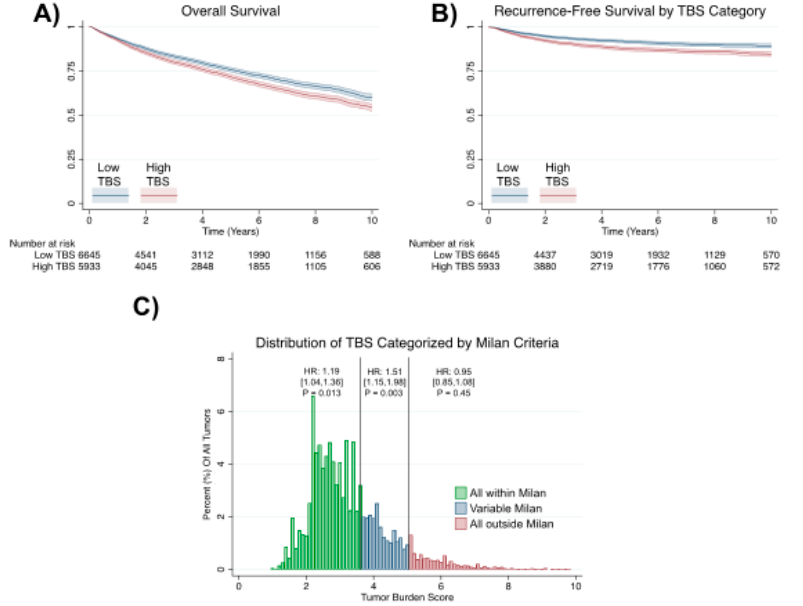
Figure 1. TBS and post-transplant outcomes. Patients with a high TBS had worse ( A ) overall survival, and ( B ) recurrence-free survival. ( C ) A higher TBS was associated with a higher hazard of recurrence at values that were either all within or variably within the Milan criteria. HR, hazard ratio.